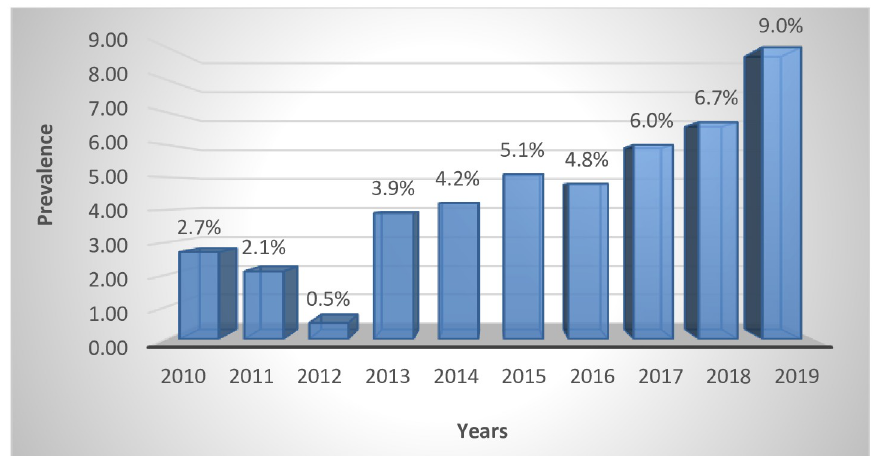
Fig 1. Prevalence of preterm babies for the 10 years period at CCTH.